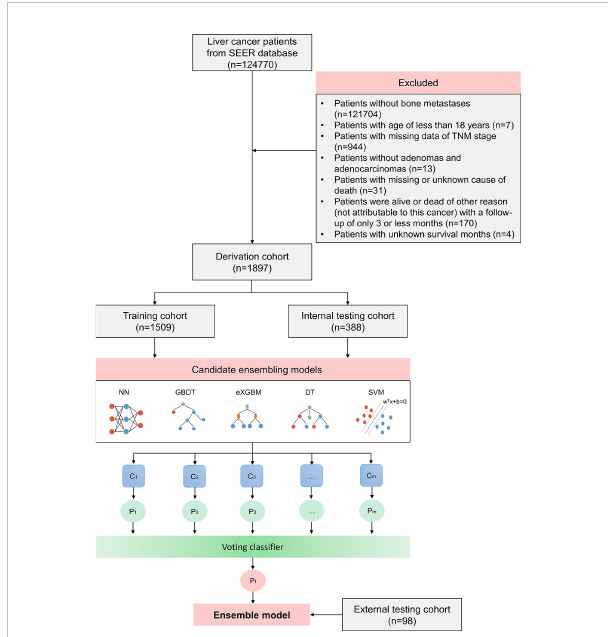
FIGURE 1 Flow chart outlining patient ’ s enrollment, study design, and ensemble machine learning